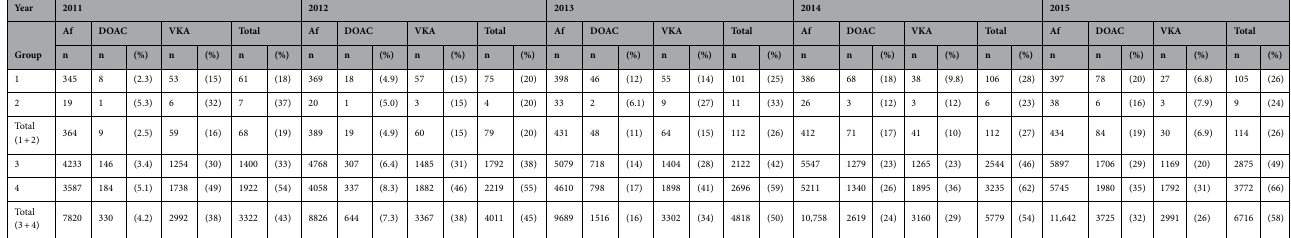
Table 2. The proportion of anticoagulant prescriptions by group of stratified cerebral infarction risk and bleeding risk. Group 1: CHA 2 DS 2 -VASc = 1, HAS-BLED = 1, 2; Group 2: CHA 2 DS 2 -VASc = 1, HAS-BLED ≧ 3; Group 3: CHA 2 DS 2 -VASc ≧ 2, HAS-BLED = 1,2; Group 4: CHA 2 DS 2 -VASc ≧ 2, HAS-BLED ≧ 3. * Af Atrial fibrillation. † VKA Vitamin K antagonist. ‡ DOAC direct oral anticoagulant. § CHA 2 DS 2 -VASc score heart failure, hypertension, age ≥ 75 years (doubled), diabetes mellitus, prior cerebral infarction or TIA (doubled), vascular disease, age 65–74 years, female sex. || HAS-BLED score hypertension, kidney dysfunction, liver dysfunction, prior cerebral infarction or TIA, prior bleeding or predisposition to bleeding, age ≥ 65 years, use of AP and NSAIDs, alcoholism. # NSAIDs non-steroidal anti-inflammatory drugs. ** TIA transient ischemic